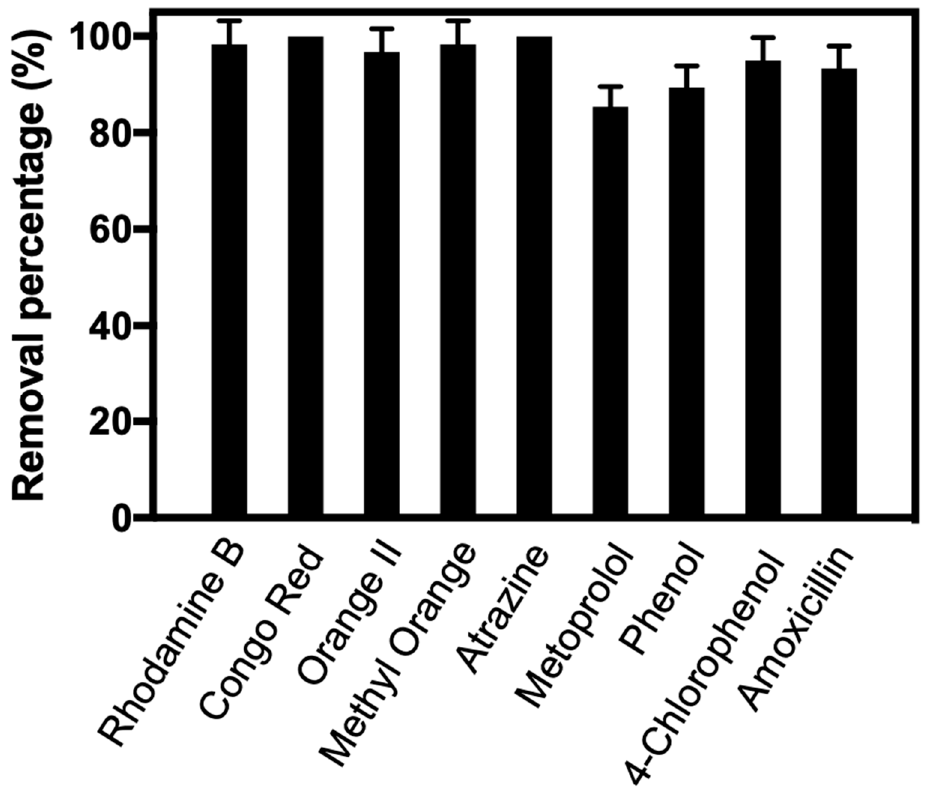
Figure 10. Degradation of selected compounds by the electro/Mn(II)/sulfite process. Reaction 0.2 mM Mn(II), 2 mM sulfite, 5 mM sulfate as supporting electrolyte, 10 µ M organic compound, 100 mA conditions: 0.2 mM Mn(II), 2 mM sulfite, 5 mM sulfate as supporting electrolyte, 10 μ M organic electric current, and pH compound, 100 mA electric current, and pH 6.